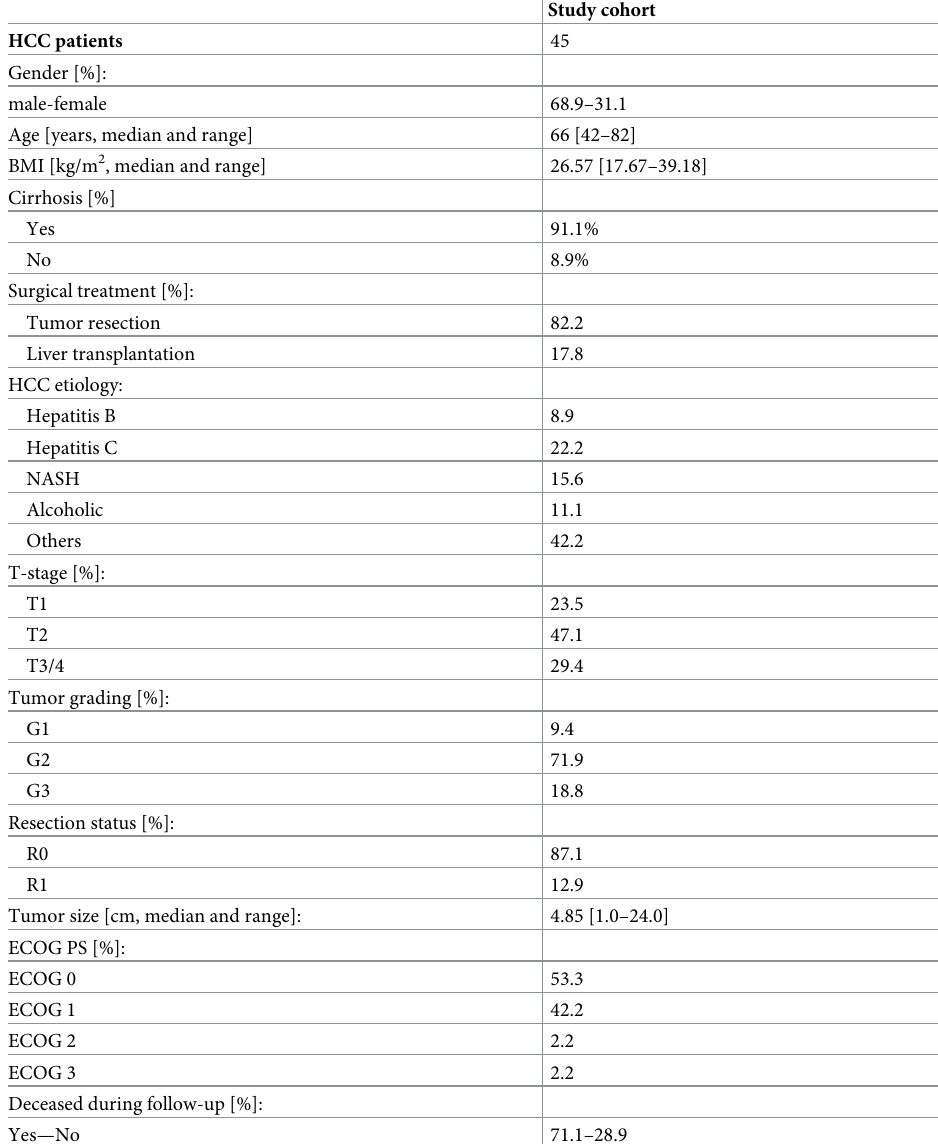
Table 1. Patient